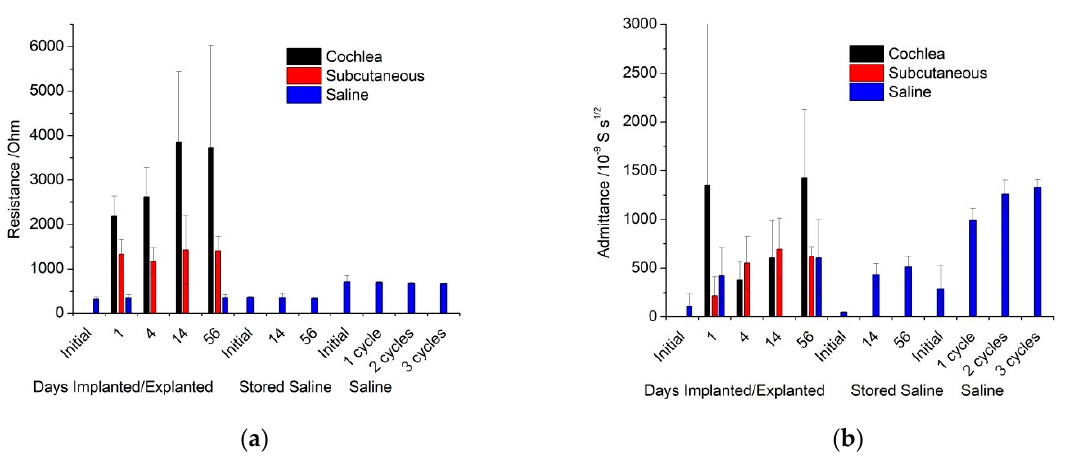
Figure 4. Equivalent circuit parameters ( a ) resistance and ( b ) admittance over time; initial, explanted, or stored electrode response in saline, or in vivo response in the cochlea or subcutaneously.